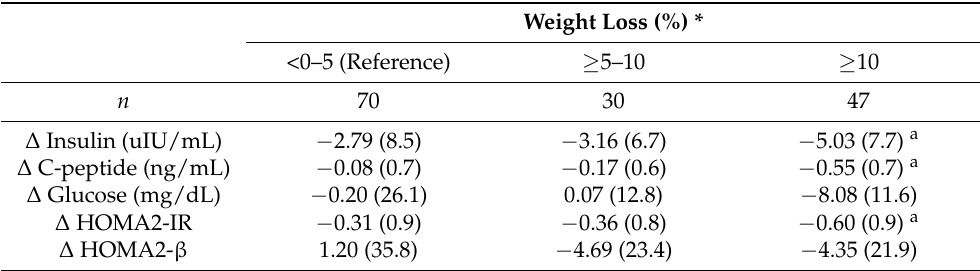
Table 3. Changes in biomarkers of insulin sensitivity among WISER Survivor participants stratified according to weight loss and tertiles of change in fat mass, change in lean mass, and change in aerobic